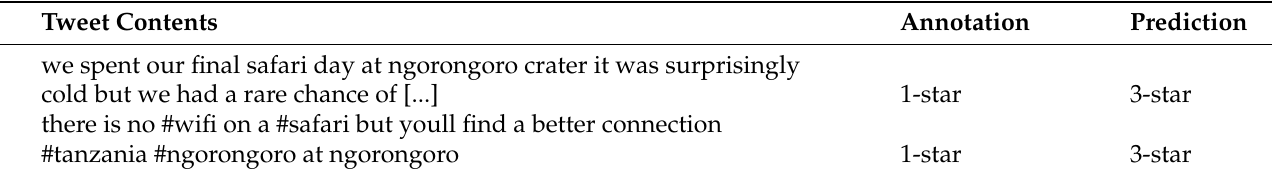
Table 11. Examples of misjudged